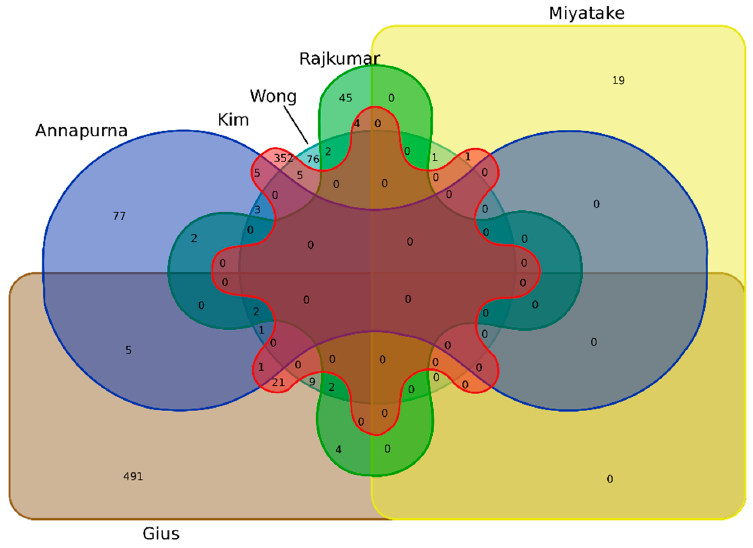
Figure 2. Venn diagram of the DEGs from all the selected studies.